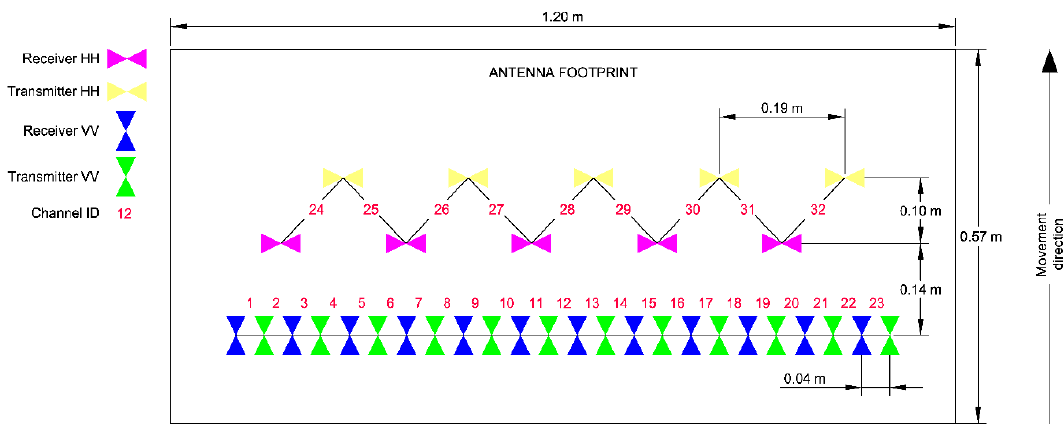
Figure 3. Diagram of Leica Stream C GPR antennas configuration.